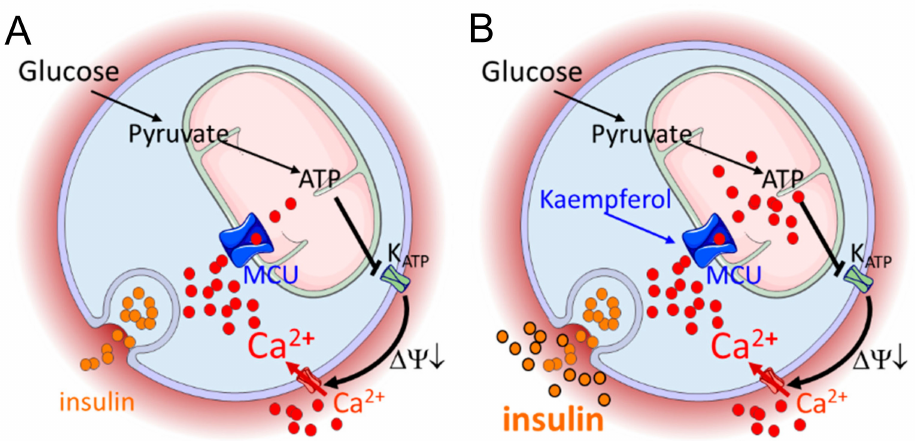
Figure 7. Proposed mechanism of kaempferol-dependent metabolism / secretion coupling in glucose-stimulated pancreatic β -cells. The glucose-stimulated insulin secretion ( A ) is potentiated by kaempferol, via mitochondrial calcium rise enhancement ( B